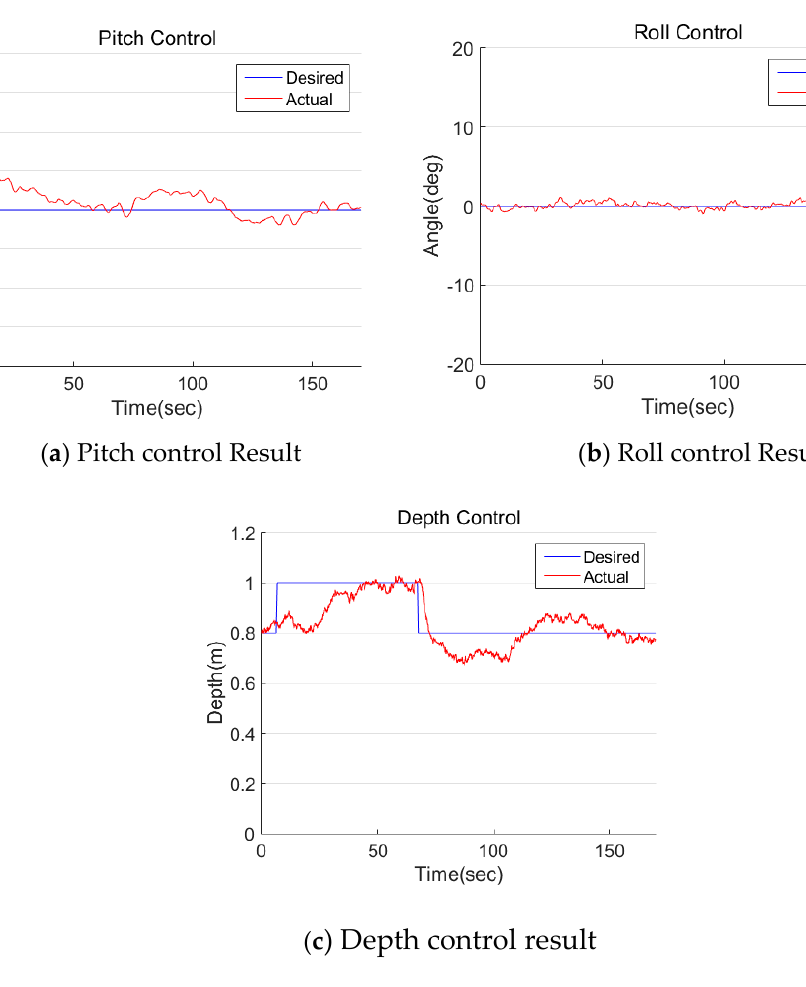
Figure 10. TUP operation sequence.